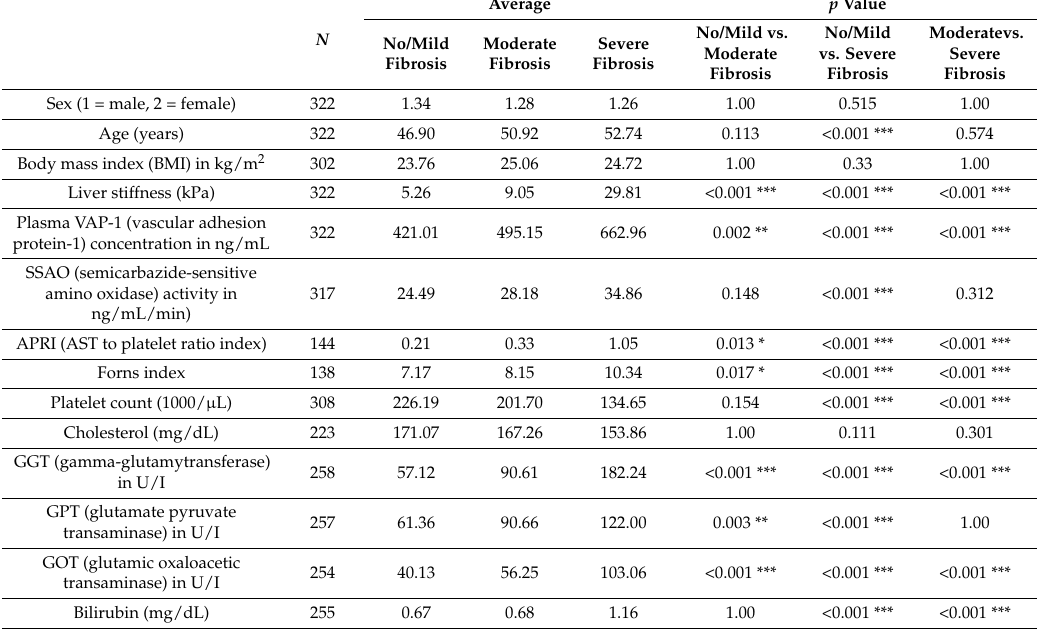
Table 1. Characteristics of the study cohort. The classification between no/mild, moderate and severe fibrosis is based on liver stiffness as assessed by transient elastography (Fibroscan ® ). No/mild